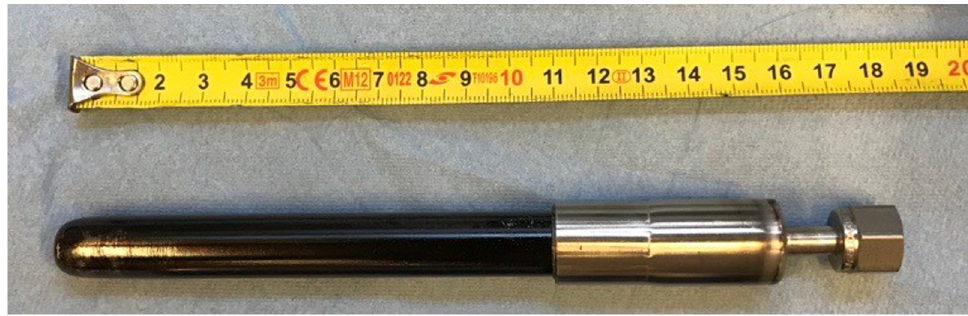
Figure 2. Double-skinned membrane with a fingerlike configuration and the other end sealed.